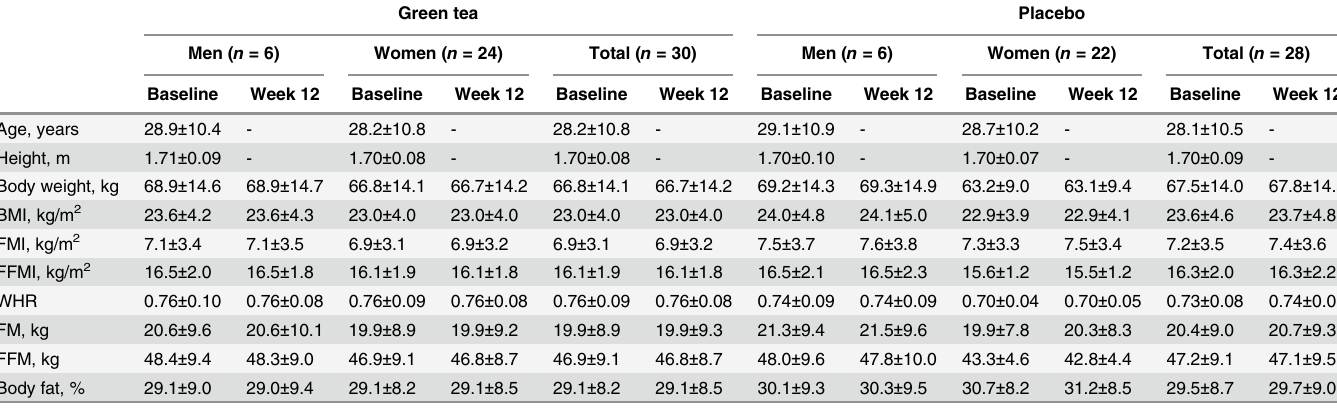
Table 2. Subject characteristics at baseline and week 12 in the green tea and placebo groups (n =